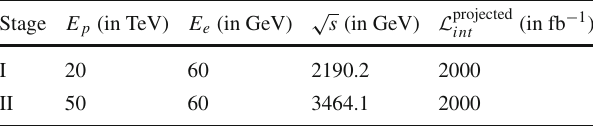
Table 14 Beam and Centre of Mass energies along with projected inte- grated luminosities at FCC-he Stage E p (in TeV) E e (in GeV)